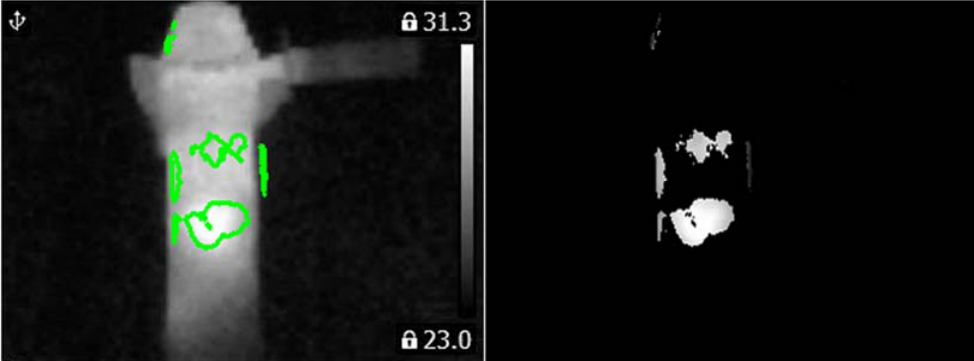
Figure 20. Values of the matrix V for the thermal image of the angle grinder with 2 blocked air inlets (indicated by the green line).